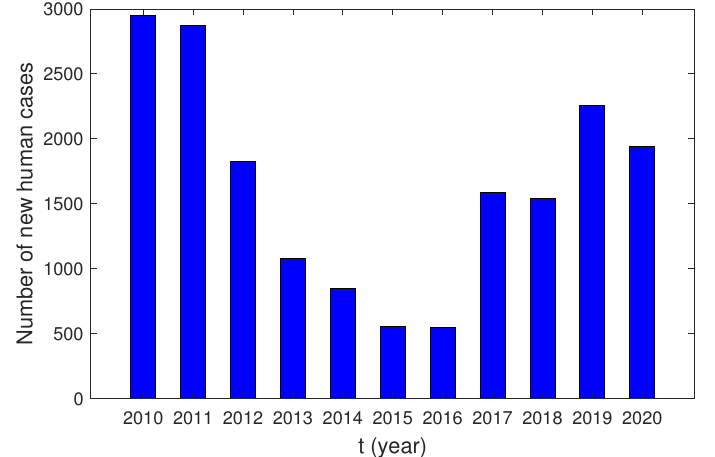
Figure 1. Number of human brucellosis cases in Hinggan League from January 2010 to January 2020 (data from NNDRS